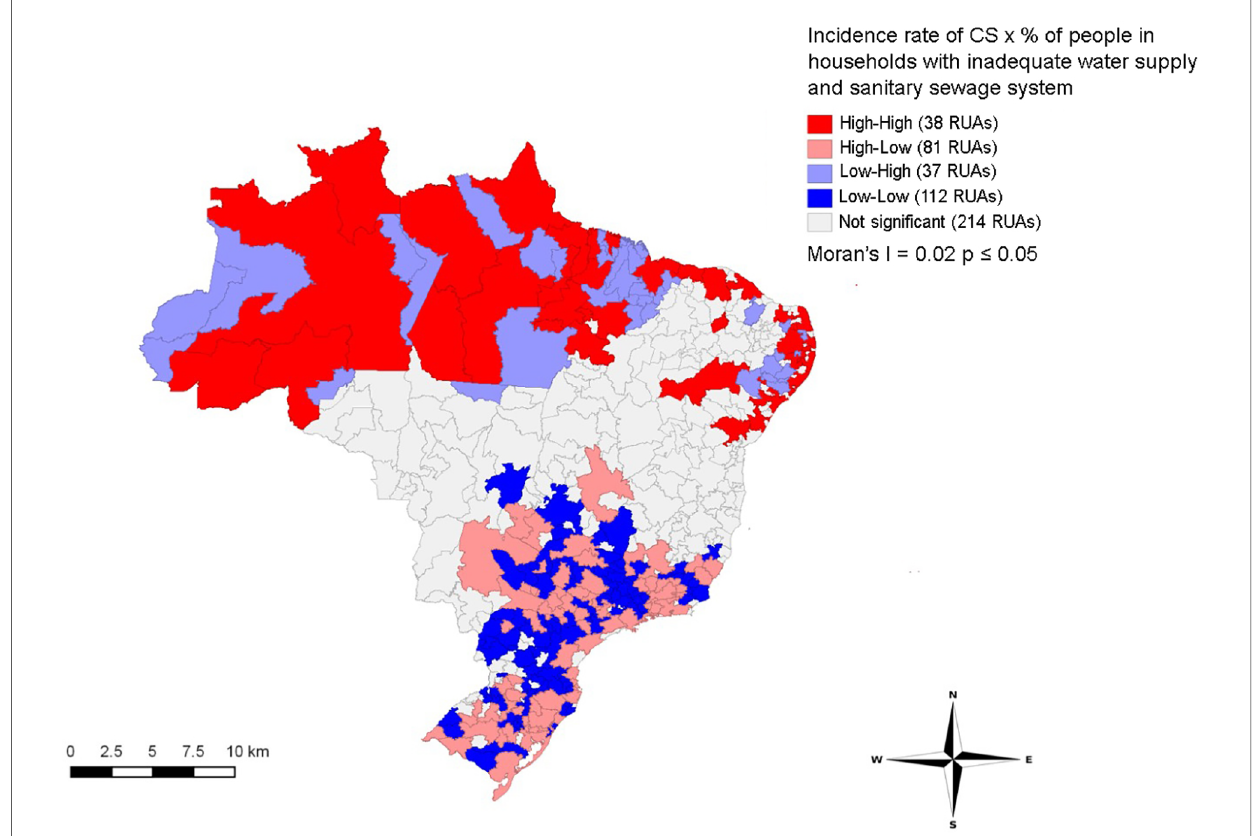
FIGURE 4 Distribution of LISA bivariate spatial correlation clusters of congenital syphilis incidence rate with the socioeconomic indicator in immediate regions of urban articulation in Brazil, 2008 –